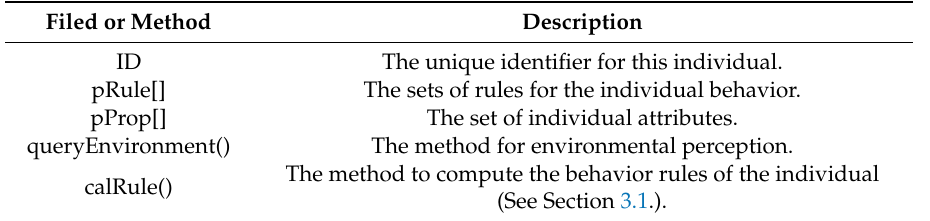
Table 2. The main attribute filed and method in CAgent.